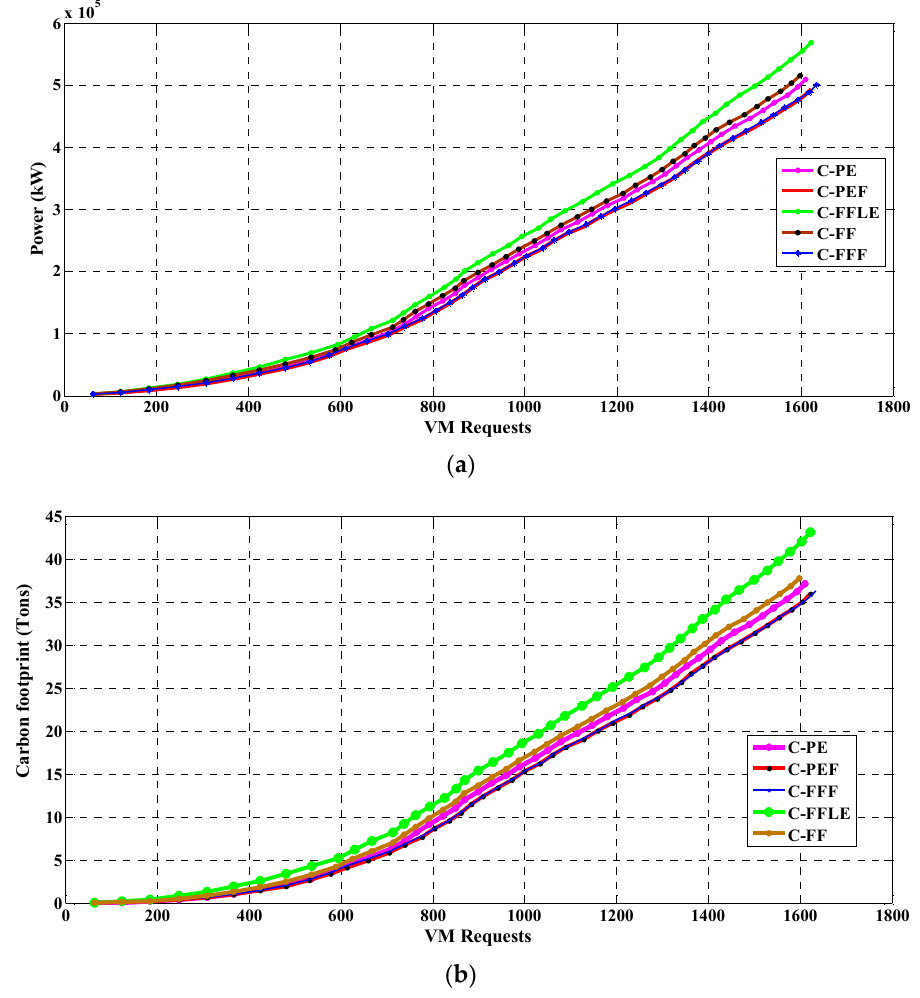
Figure 7. ( a )Power consumption and ( b ) carbon footprint comparisons of all algorithms.